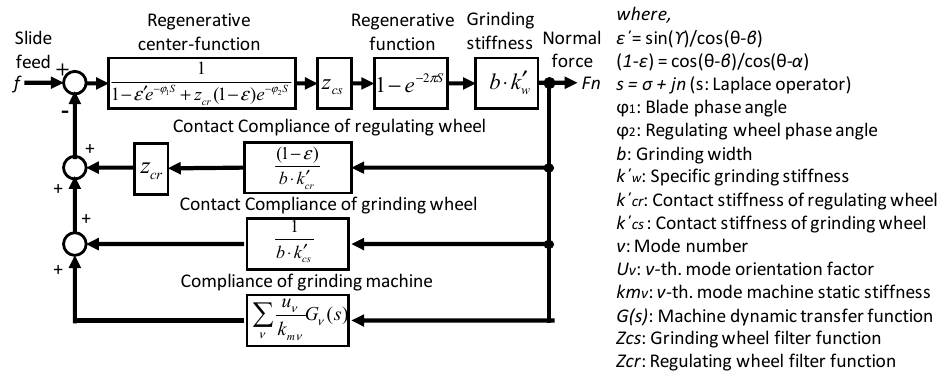
Figure 3. Block diagram of centerless grinding system.